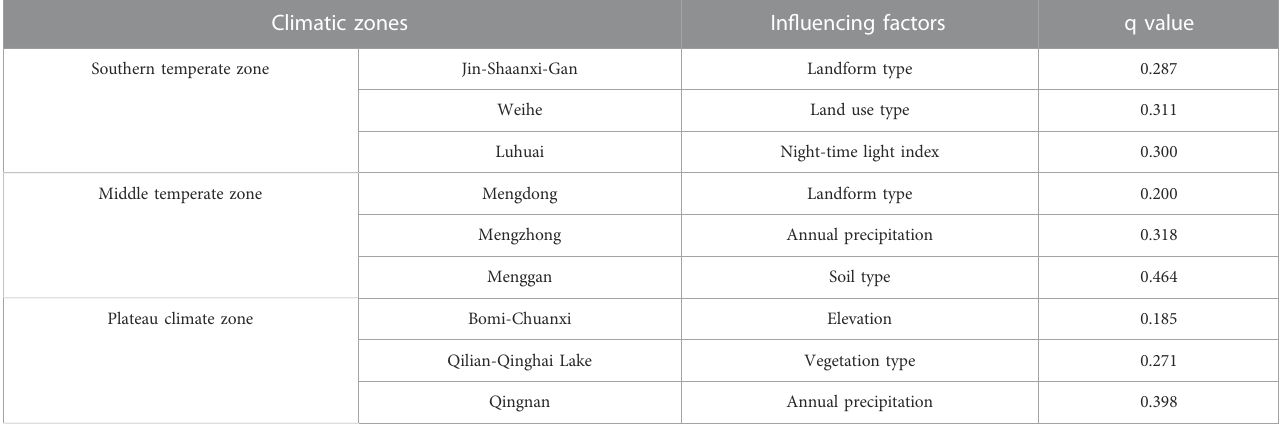
TABLE 3 Main in fl uencing factors of the NDVI in different climatic